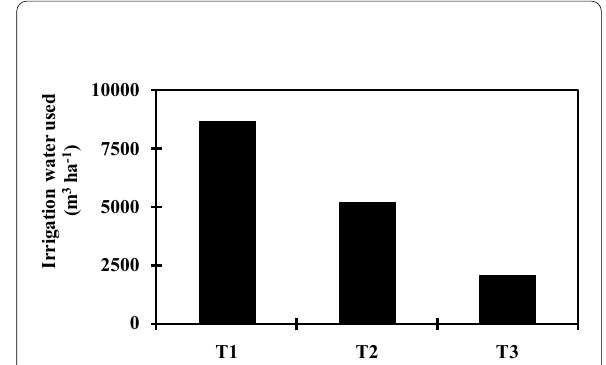
Fig. 2 Total volume of irrigation water applied during experimental period under different soil moisture regimes. T 1, T 2 and T 3 represent 30, 50 and 70% soil moisture depletion levels, respectively. The values are means ( n =